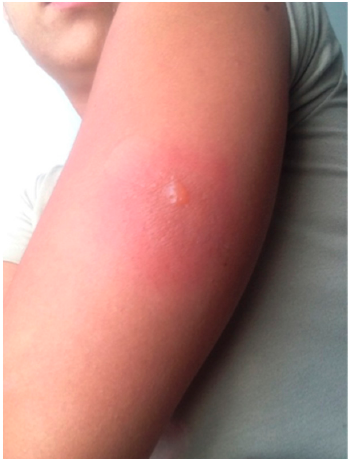
Figure 1. Day 2 following inoculation with initial formation of vesicles with surrounding erythema.